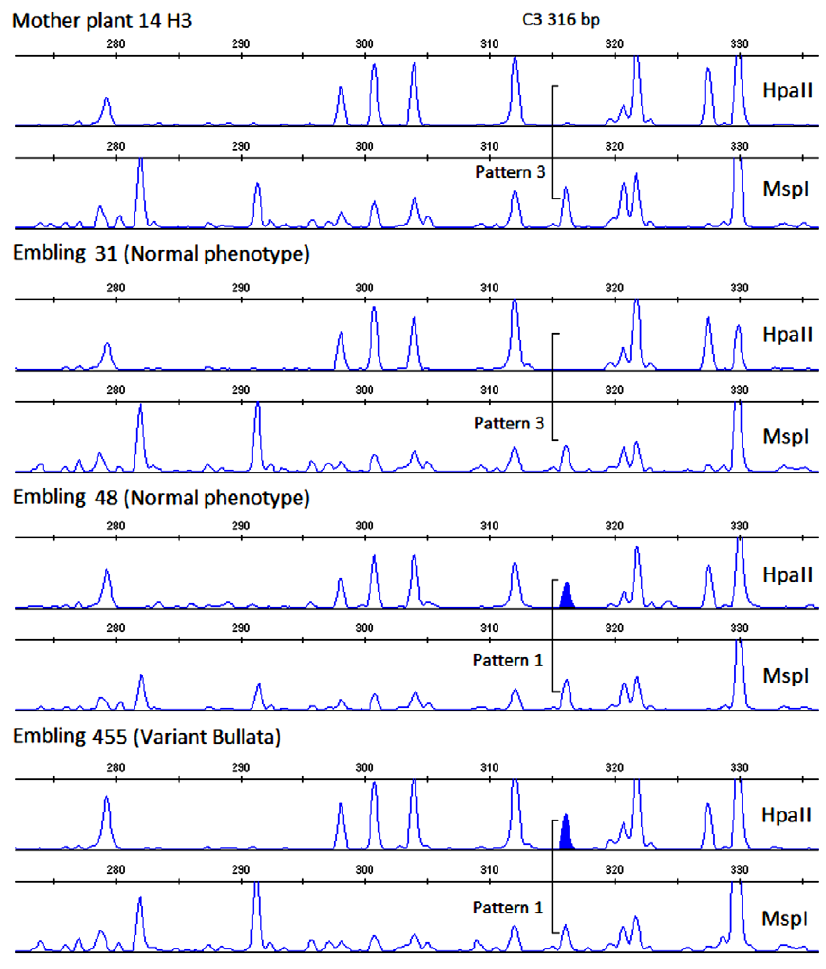
Figure 4. Representation of MSAP electropherograms observed for coffee mother plants and embling progeny using the isoschizomers Hpa II and Msp I. Illustration of the pattern variation obtained for normal and variant phenotypes within the embling progeny.